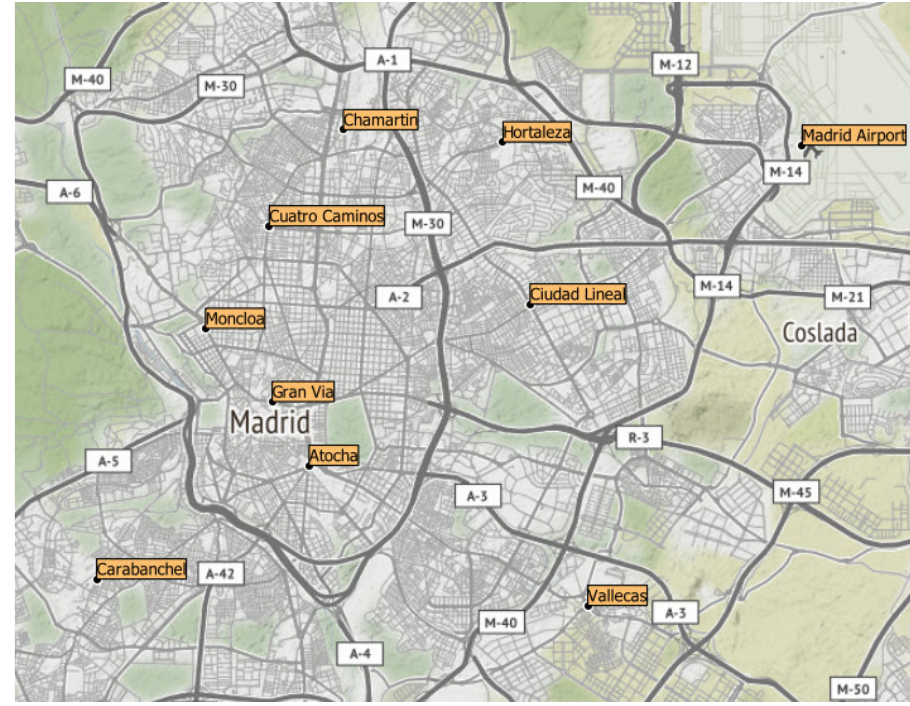
Figure 1. Madrid city and selection of the ODs of the requested rides. Additional exogenous variables were added using feature engineering techniques